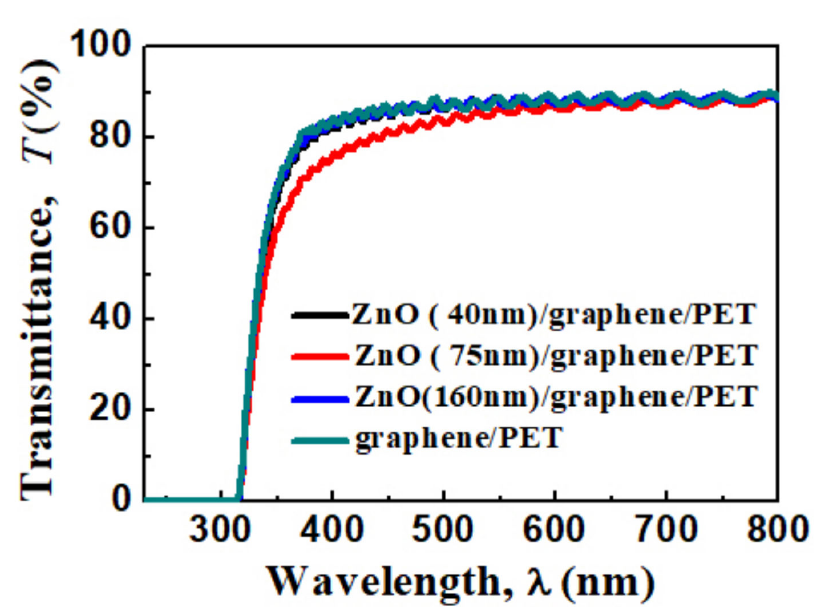
Figure 5. Optical transmittance spectra of graphene/PET and ZnO (40, 75, and 160 nm thick-